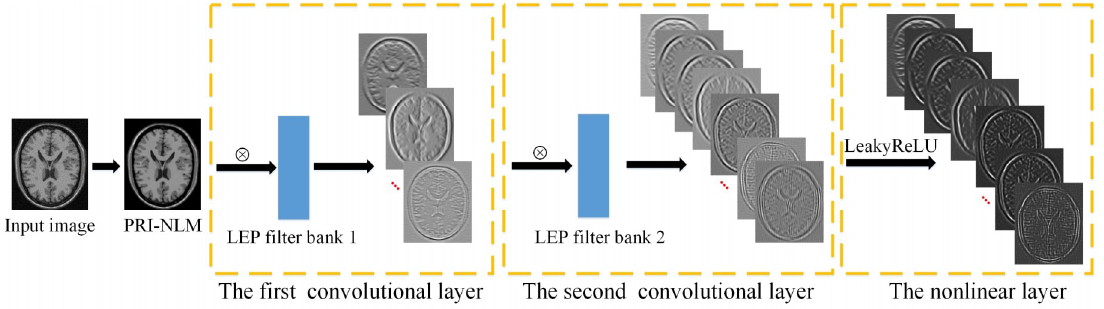
Figure 1. A block diagram of the proposed LEPNet model.